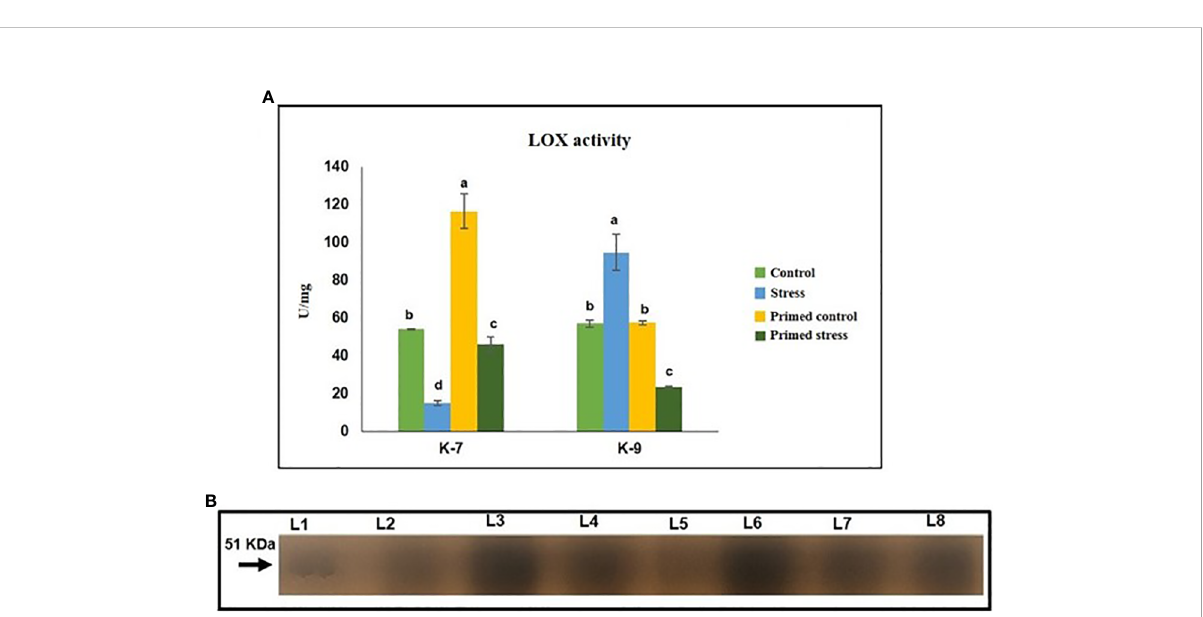
FIGURE 10 Effect of melatonin priming on the activity of lipoxygenase enzyme in drought sensitive (K-7) and drought-tolerant (K-9) varieties under drought stress. (A) Lipoxygenase activity (spectrophotometric detection) and; (B) in-gel staining activity. Data represents mean values ± SD of minimum 3 independent experiments. Different alphabets within the group represent signi fi cant differences among treatments according to Duncan ’ s multiple range test at P <